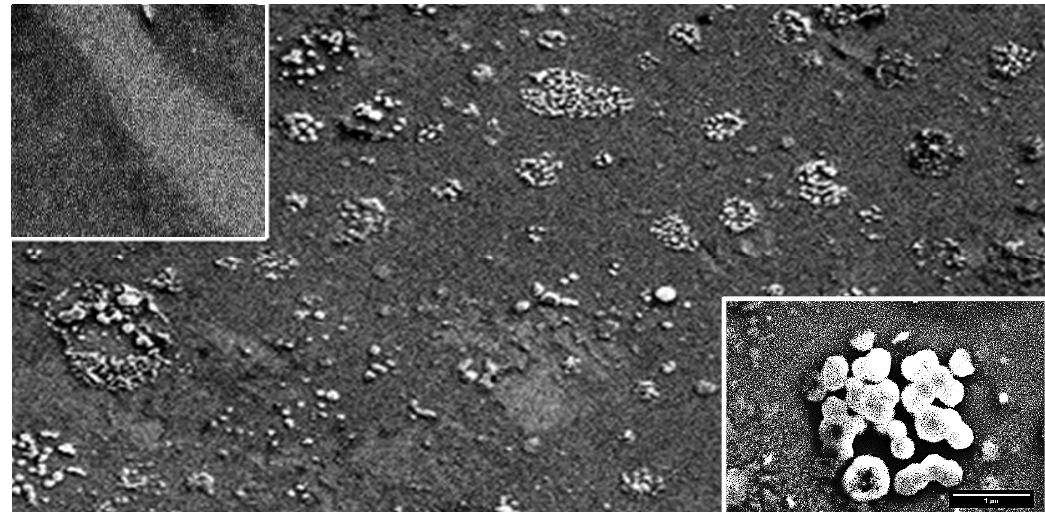
Figure 9. SEM image of a 45 μ m × 150 μ m graphene chip from Group 1. Inset 1 ( left, top ) shows a 5 μ m × 5 μ m section with boundaries of functionalized graphene (dark areas) and non-functionalized graphene (light area in the middle). Inset 2 ( right, bottom ) shows a 2.7 μ m × 4.2 μ m region with virus aggregates, located in a recess with a facet close to a hexagonal structure.